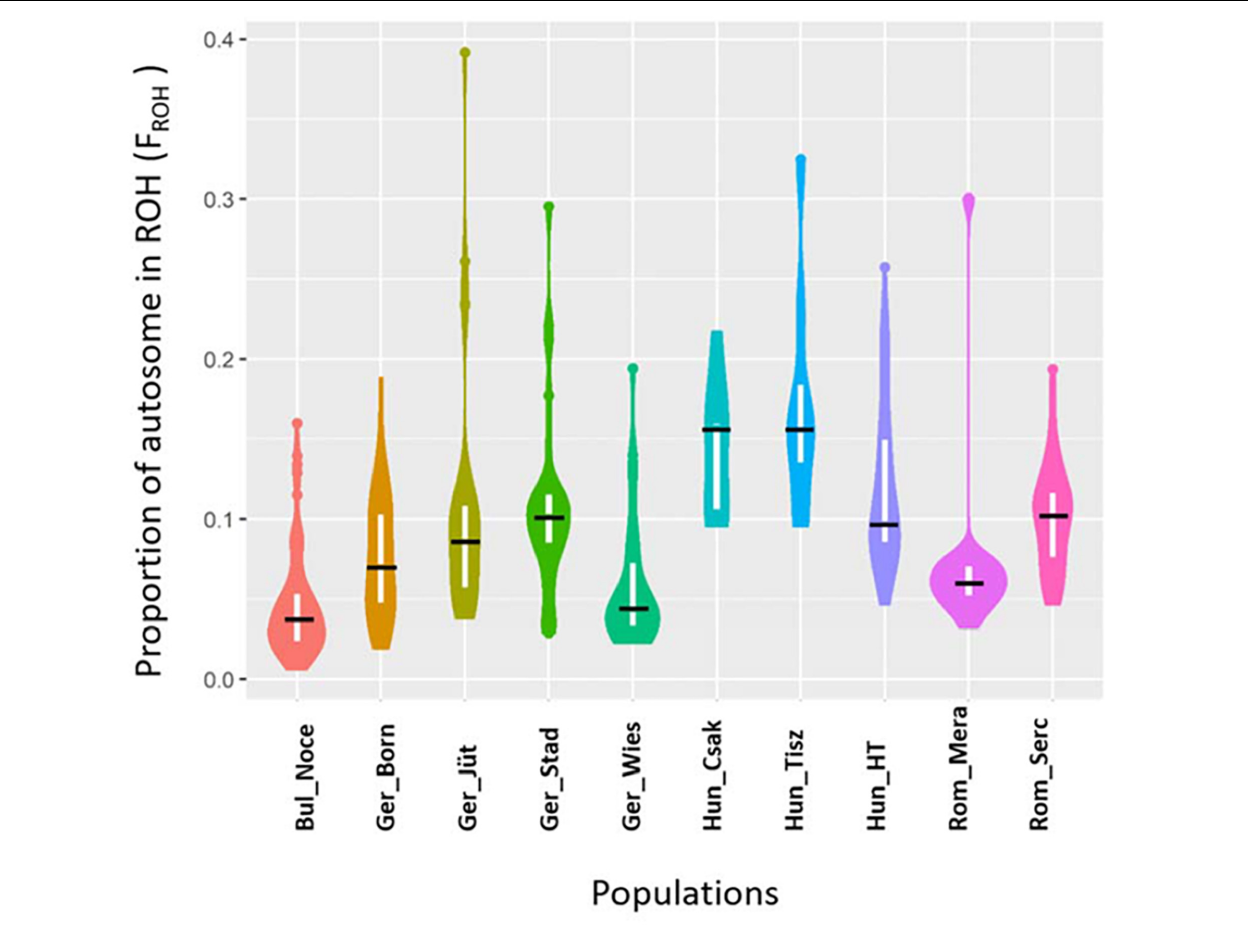
FIGURE 7 | Violin Plot reporting the proportion of autosome covered in run of homozygosity (ROH) aka Genomic inbreeding coefficients (F ROH ) in Buffalo populations from Bulgaria (Bul_Noce), Romania (Rom_Mera, Rom_Serc), Hungary (Hun_Csak, Hun_Tisz, Hun_HT), and Germany (Ger_Born, Ger_Jüt, Ger_Stad, Ger_Wies). The black line indicates the median of F ROH within the breed. Abbreviations and sample numbers are specified in Figure 3